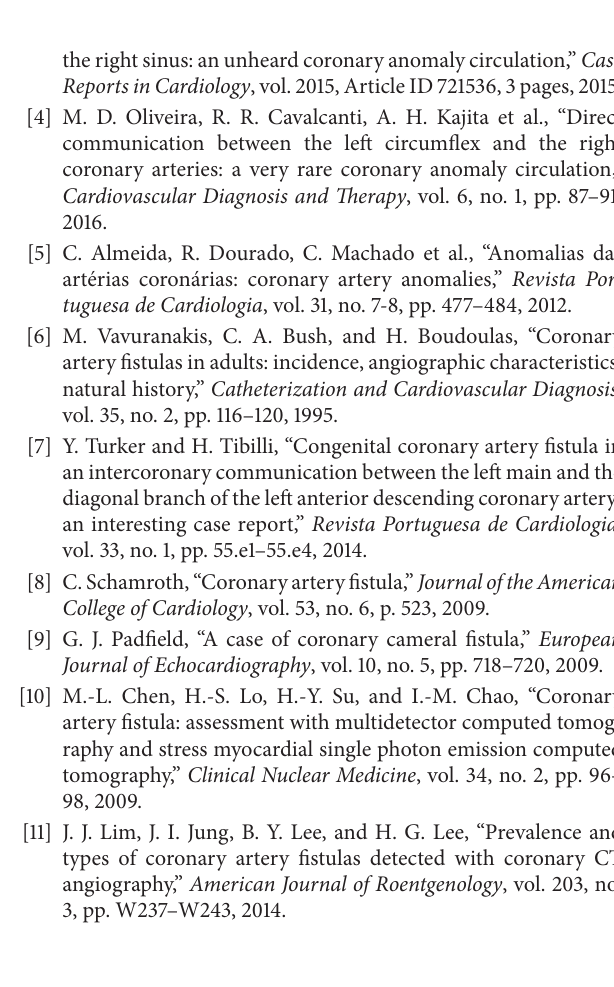
Figure 3: Selective contrast injection in the LCA showing the well developed fistulae, from the left main and, especially, the first diagonal branch to the pulmonary artery (retrogradely filled). LCA: left coronary artery; LAD: left anterior descending; LCx: left circumflex; Dg1: first diagonal